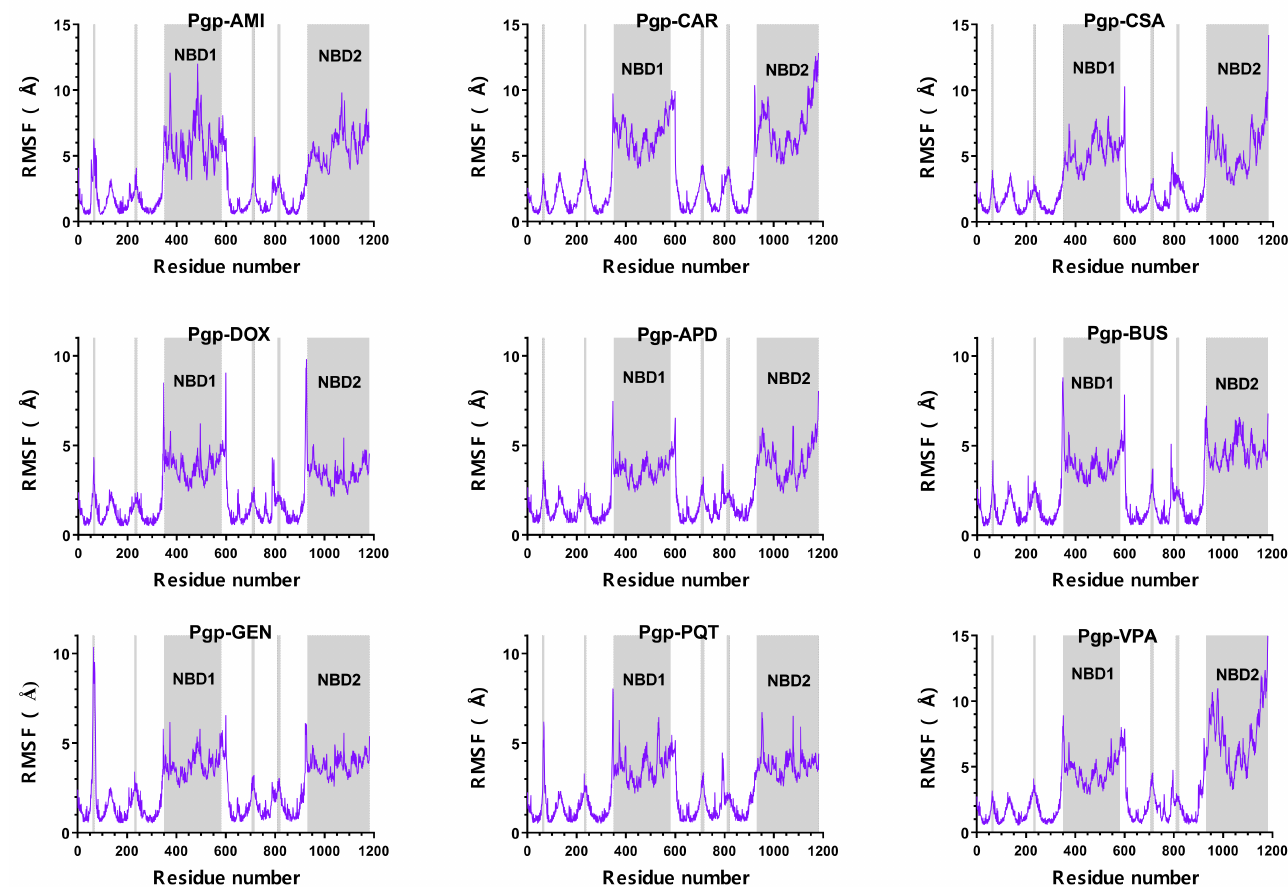
Figure 3. Per-residue RMSF for the simulated ligand–P-gp complexes. The residue numbers do not correspond to the IDs in the PDB file of the cryo-EM structure, but are consecutive, as required by the simulation